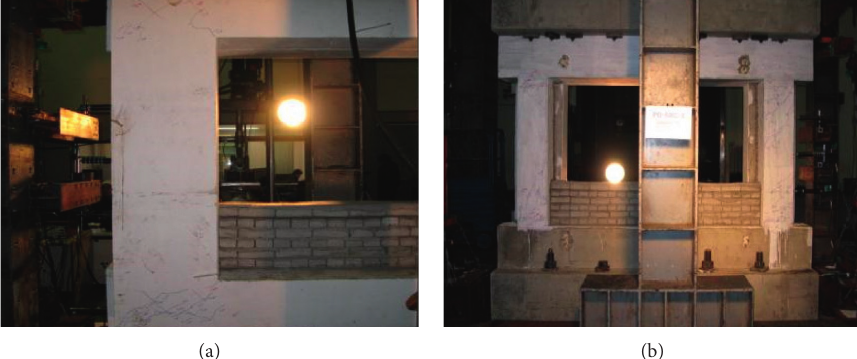
Figure 26: Cracks appeared in the PD-BESRCF specimen during pseudodynamic testing at 375 gal after (a) 2.65s with lateral displacement of 19.1mm and force of 401kN, and (b) during the final stage (7s).